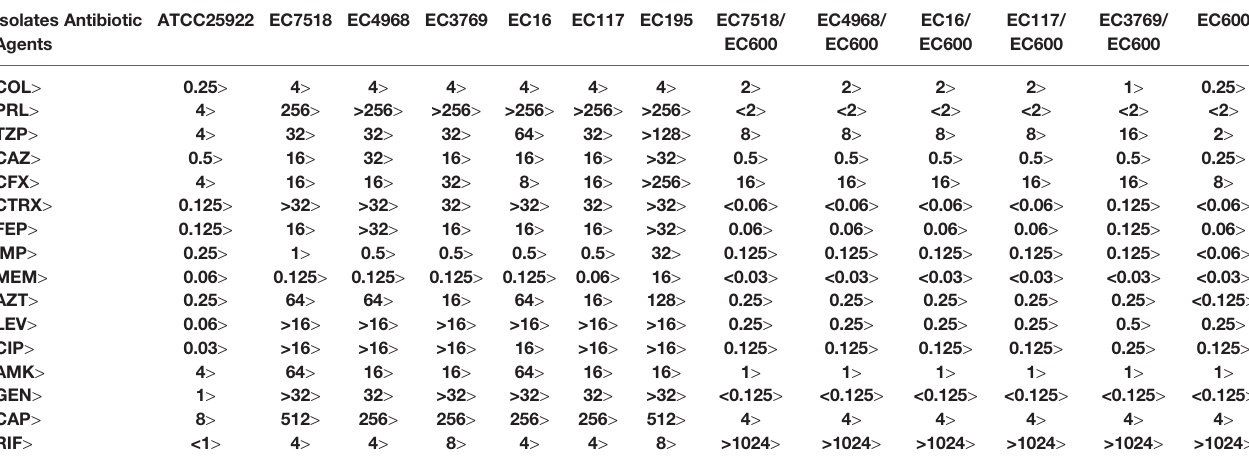
TABLE 1 | MIC values for original isolates and their mcr-1 -positive transconjugants (mg/L). Isolates Antibiotic